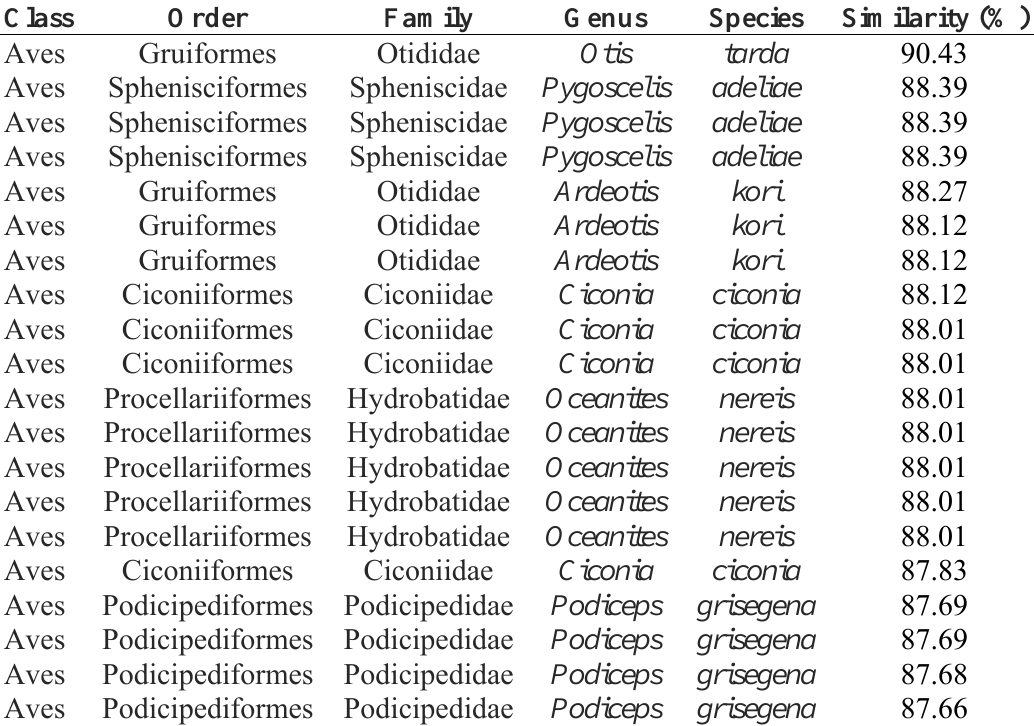
Table 2. List of closely-related species to Houbra Bustard, according to the Barcode of Life Data (BOLD) website search